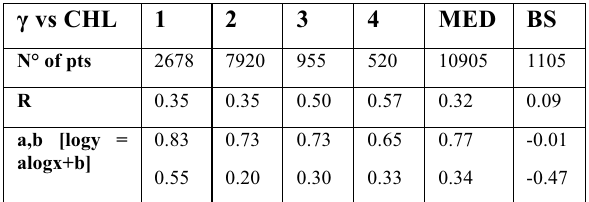
Table 1. Results of correlation coefficients and linear fit parameters ( a, b of logY= a logX+ b ) between γ and b . bp